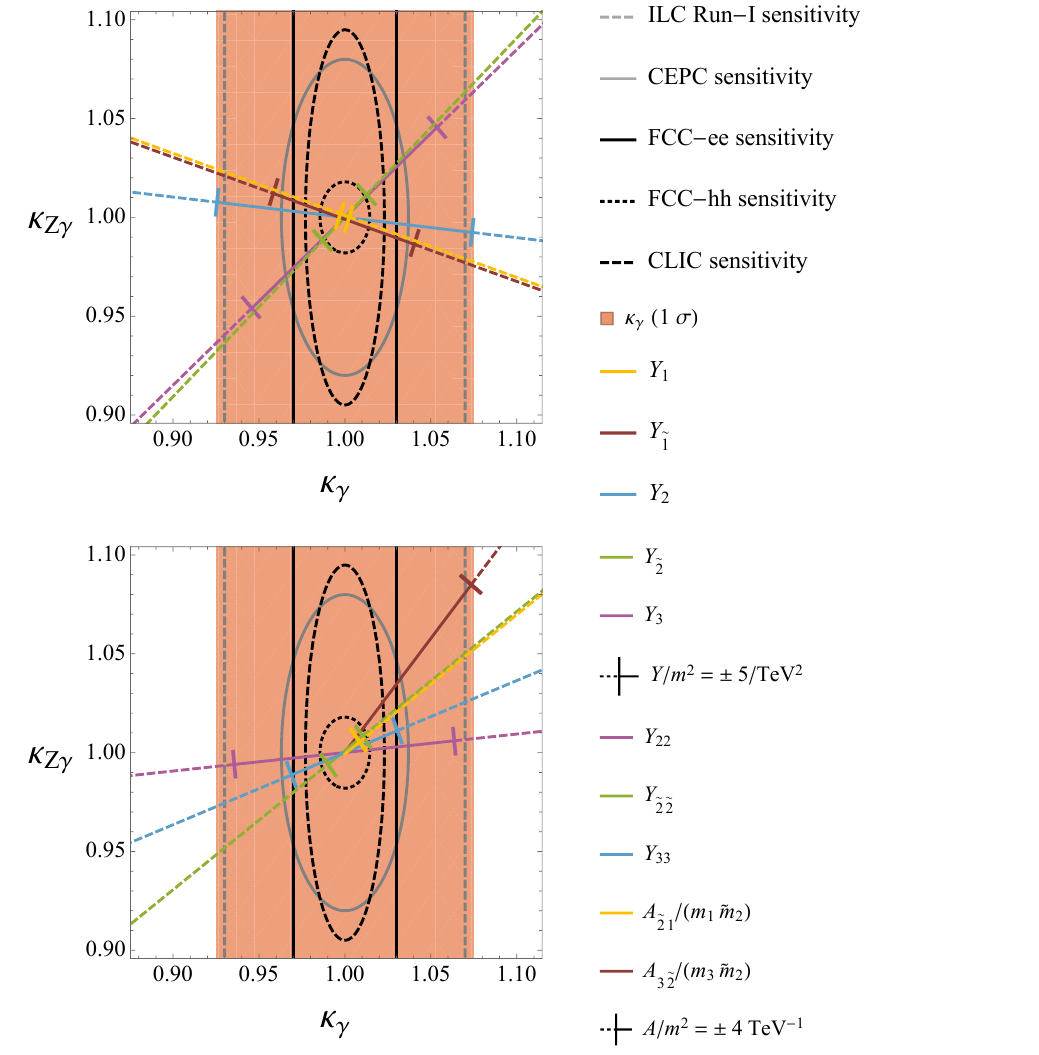
Figure 7. Correlations between κ γ and κ Zγ for the different Lagrangian parameters coupling LQs to the Higgs. The currently preferred regions are shown as red ellipses and the future sensitivity is indicated by the dashed and dotted